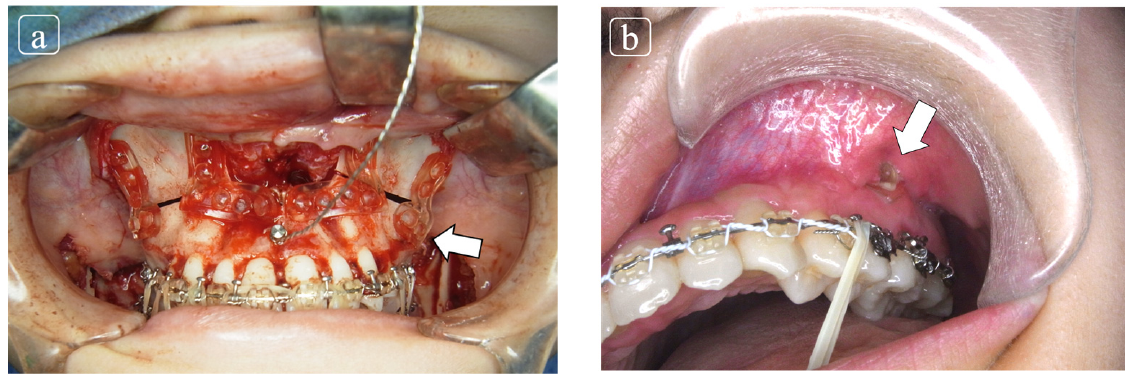
Figure 2. ( a ) The patient underwent orthogenetic surgery comprised by Le Fort I osteotomy for maxillary adjustment with internal fixation using Lactosorb ® and bilateral saggital split ramus osteotomy. ( b ) At 2 months follow-up at our outpatient clinic, the plate exposure was elucidated at infra zygomatic crest. The conservative treatment was planned and complete closure was